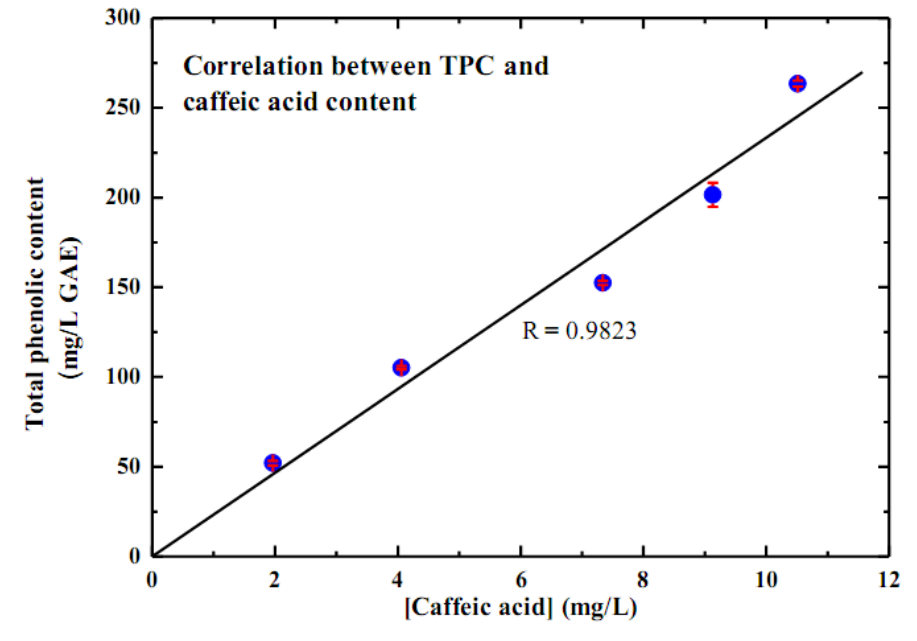
Figure 3. Correlation between total phenolic content and caffeic acid content.